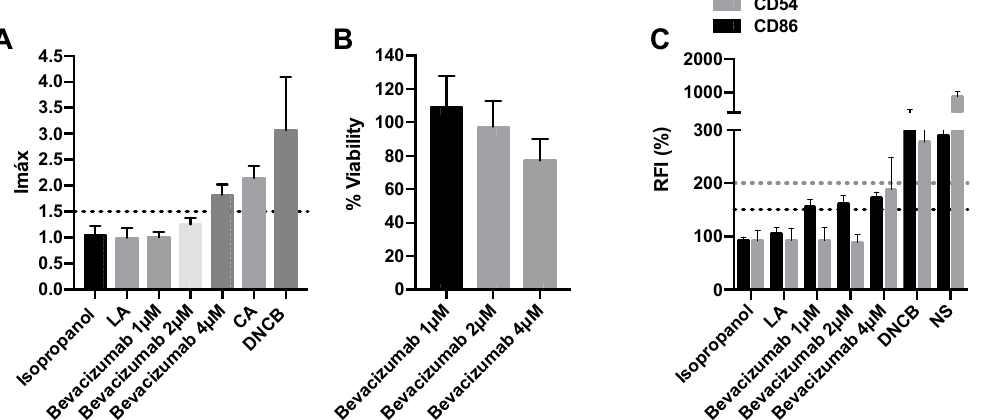
Figure 5 . Analysis of delayed-type hypersensitivity of bevacizumab by KeratinoSens TM assay and human cell line activation test (hCLAT). ( A ) KeratinoSens TM analysis after 48 h of incubation with bevacizumab. Results are expressed as luciferase activity (Imáx). ( B ) % of viability after 48 h of incubation with bevacizumab. ( C ) Human cell line activation test (hCLAT) analysis 48 h of incubation with bevacizumab. Results are expressed as relative fluorescence intensities of CD86 and CD54. Lactic acid (LA) and isopropanol were used as negative controls. 1-chloro-2,4-dinitrobenzene (DNCB), cinnamic aldehyde (CA), and nickel sulfate (NS) were used as positive controls. Shown are mean ± SEM ( n = 3). The dashed line depicts the minimum positive stimulation index.